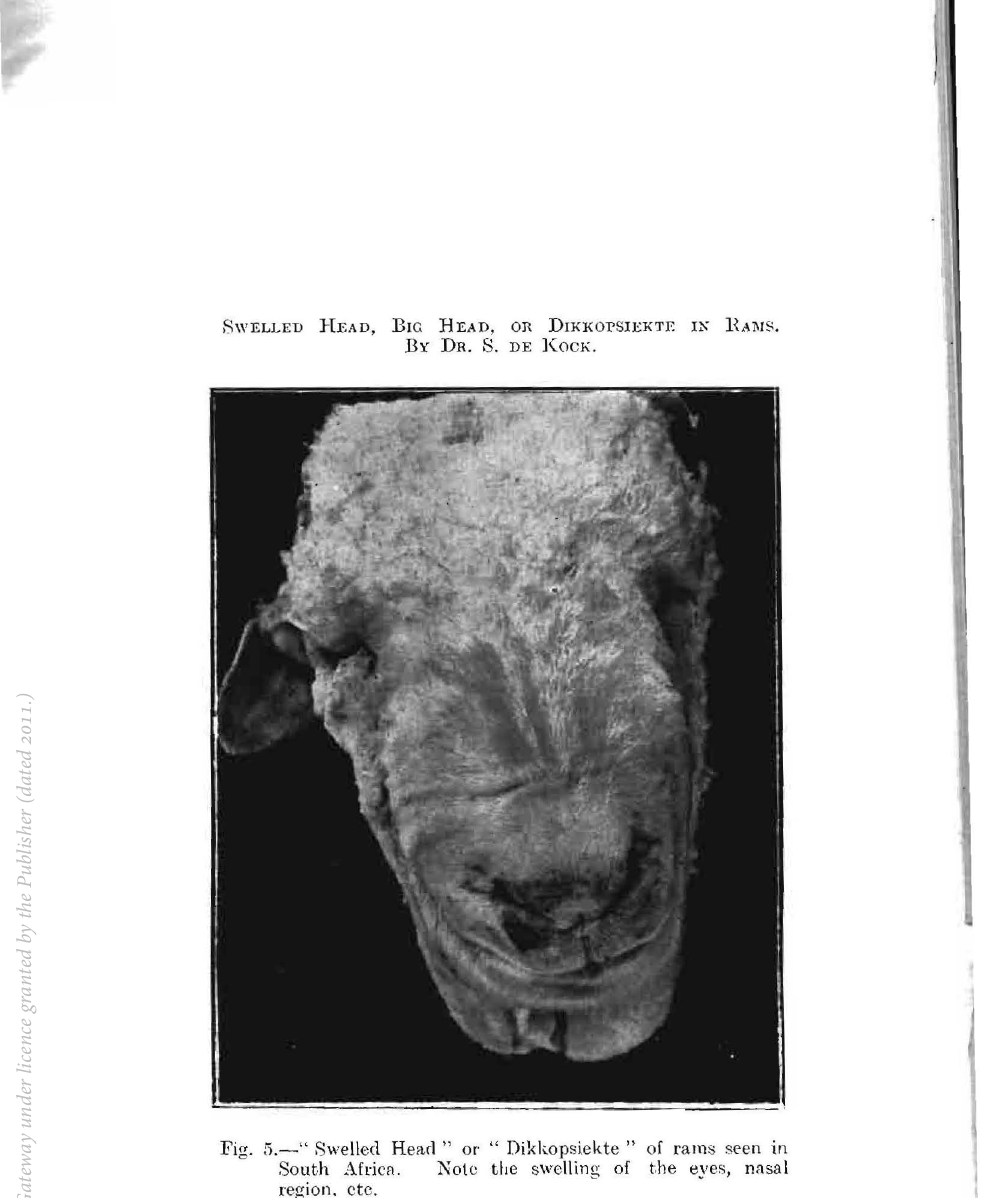
Fig. 5.-" Swelled Hearl " or " Dikkopsiekte " of rams seen in South Africa. Note the swelling of the eyes, nasal region.